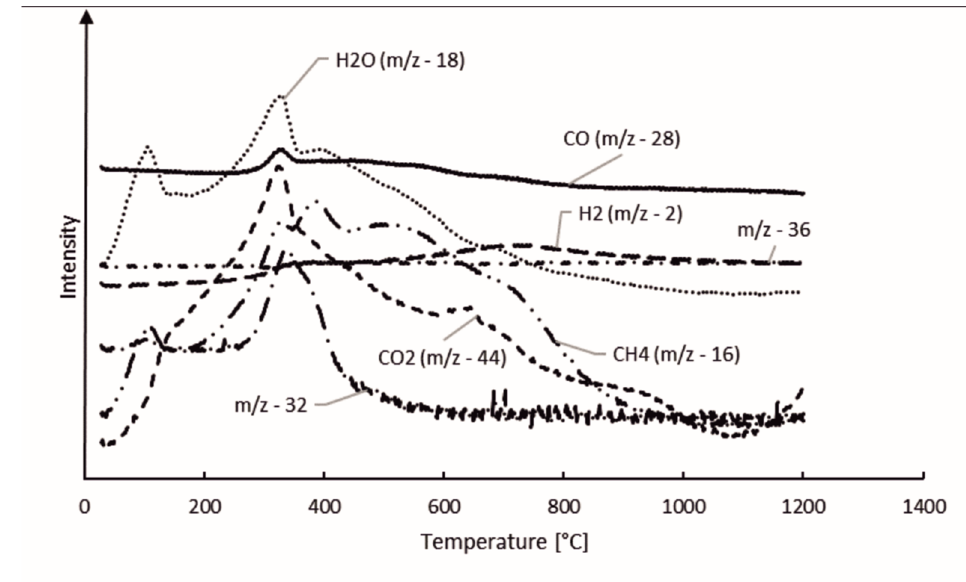
Figure 7. Hydrolysis lignin pyrolysis products.